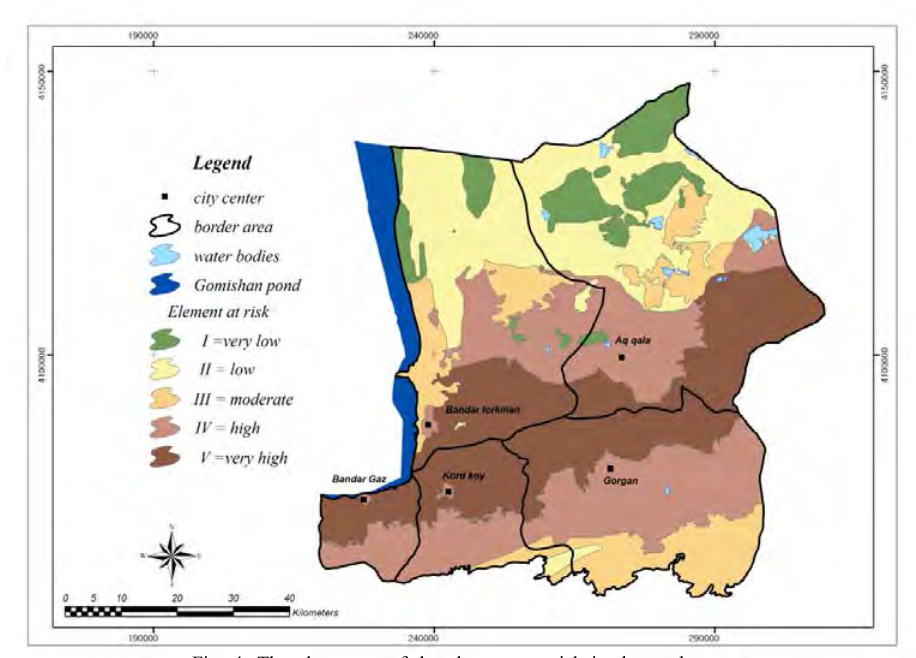
Fig. 4: The class map of the elements at risk in the study area Table 13: Frequency distribution of the percentage of each element at risk in the study area Qualitative range of the Vulnerability Vulnerability Area (m 2 ) Area vulnerability of elements at risk Class value